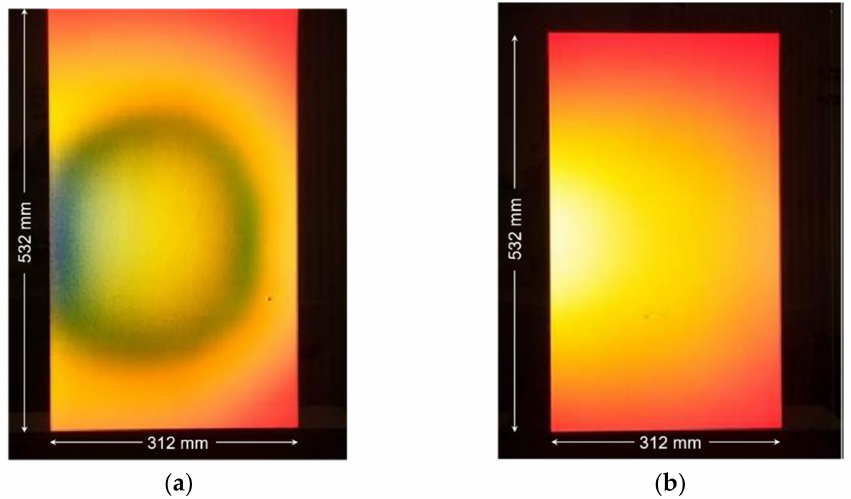
Figure 4. ( a ) A P-HOE in which the photopolymer was laminated on top of a 10 mm glass. ( b ) The result of a repeated recording. However, in this case the photopolymer was sandwiched between two 10 mm thick glass